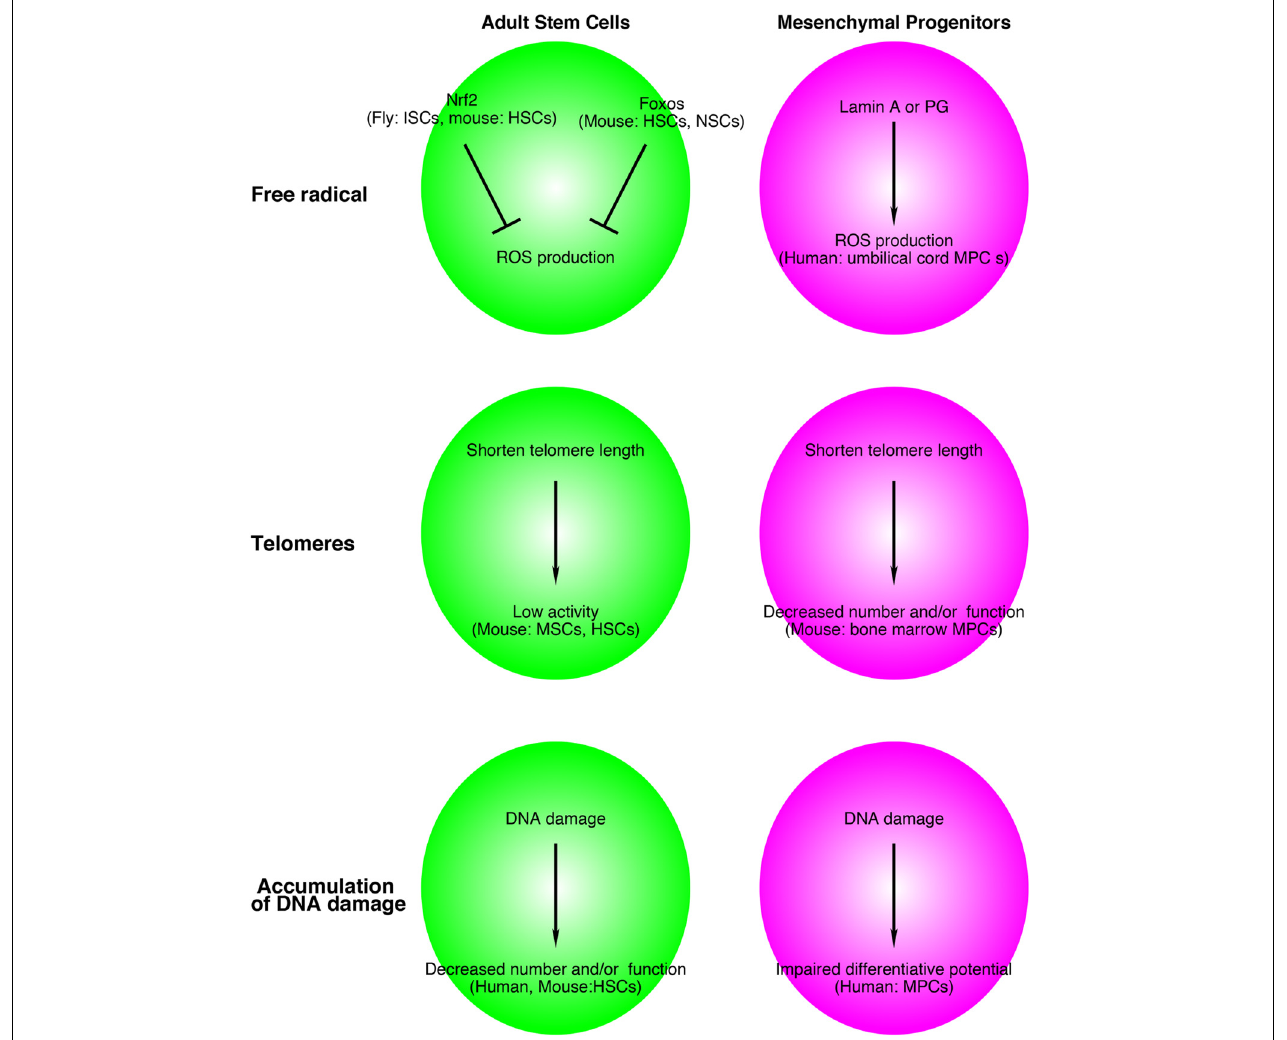
FIGURE 2 | Relationship between adult stem cell and mesenchymal progenitor theories of aging and free radicals, telomeres, and accumulation of DNA damage. Although the supporting data are still limited, this system might be applied for aged-related alterations in adult stem cells and other tissue resident mesenchymal